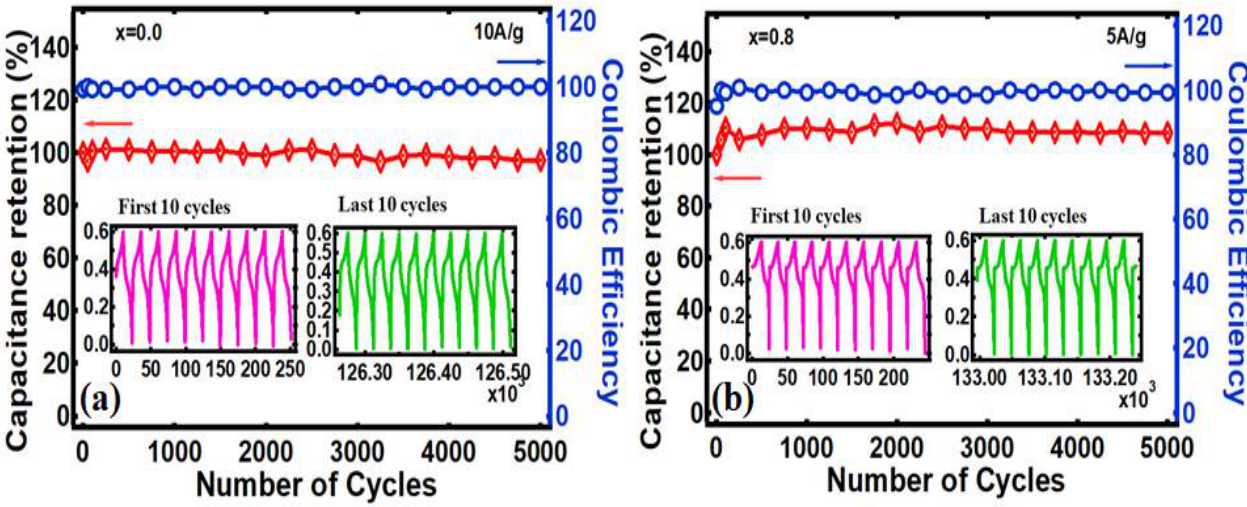
Figure 7. ( a , b ) Cyclic stability and Coulombic efficiency tested at 10 A/g and 5 A/g current density up to 5000 cycles in 3 M KOH electrolytes for Ni 1-x Al x Co 2 O 4 , x = 0, and x = 0.8.